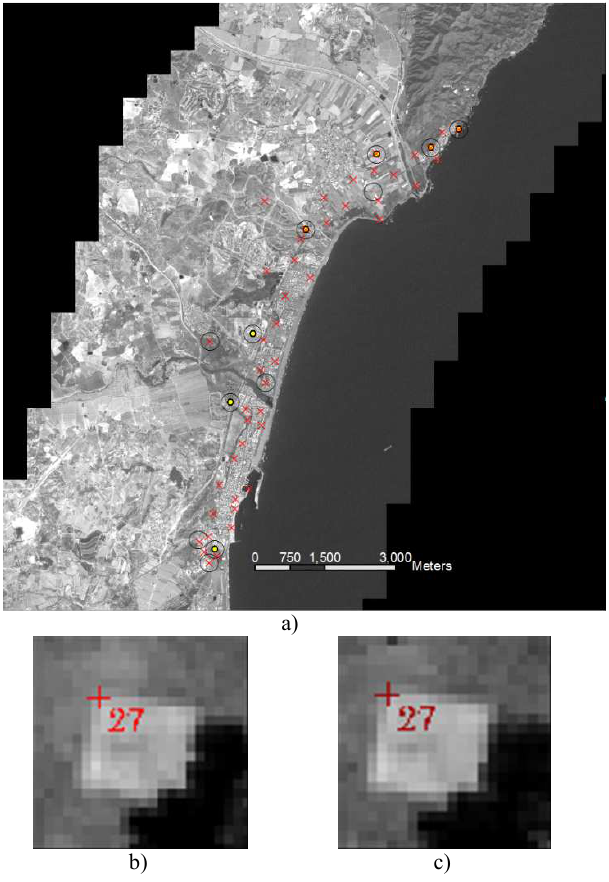
Figure 2. a) Distribution of 45 GCPs (red crosses), 12 GCPs (black circles) and 7 GCPs (yellow point) overlaid on the GeoEye-1 panchromatic image. b) GCP number 27 (forward GEO stereo). c) GCP number 27 (backward GEO